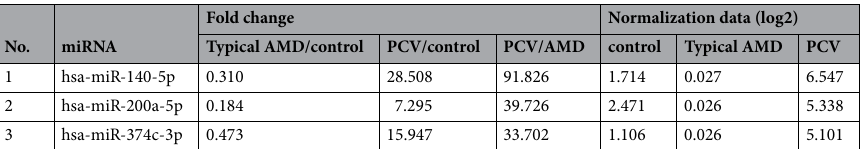
Table 4. Differentially expressed miRNAs in typical AMD-control, PCV-control, and typical AMD-PCV. AMD age-related macular degeneration, PCV polypoidal choroidal